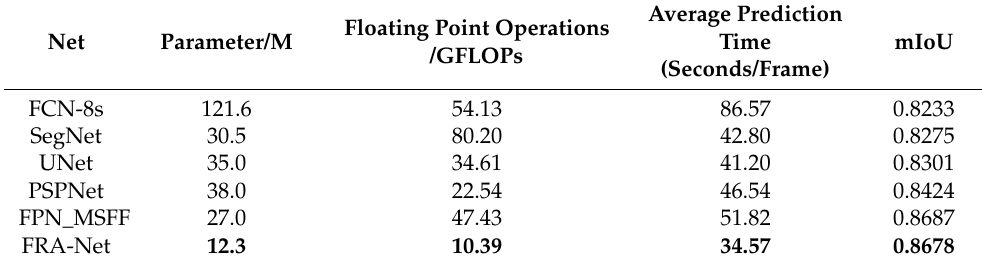
Table 2. Evaluation results of different models in the LandCover test